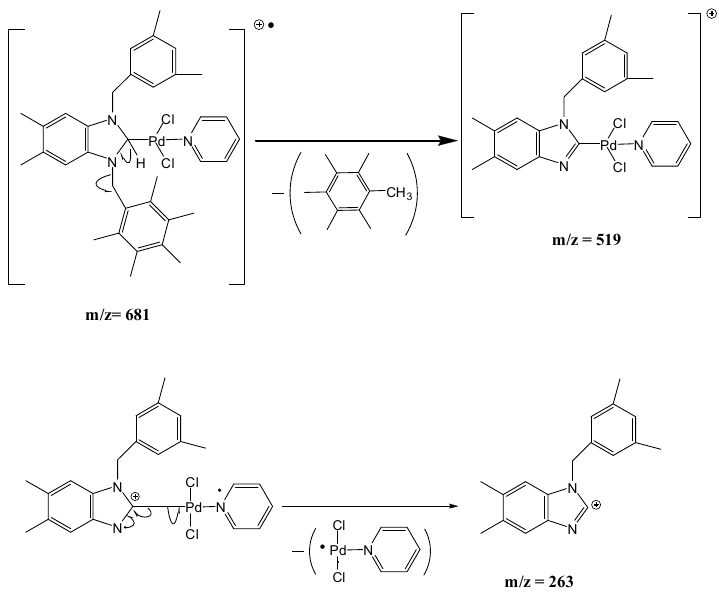
Figure 6. Mechanism of the fragmentation leading to the m / z = 263 peak.